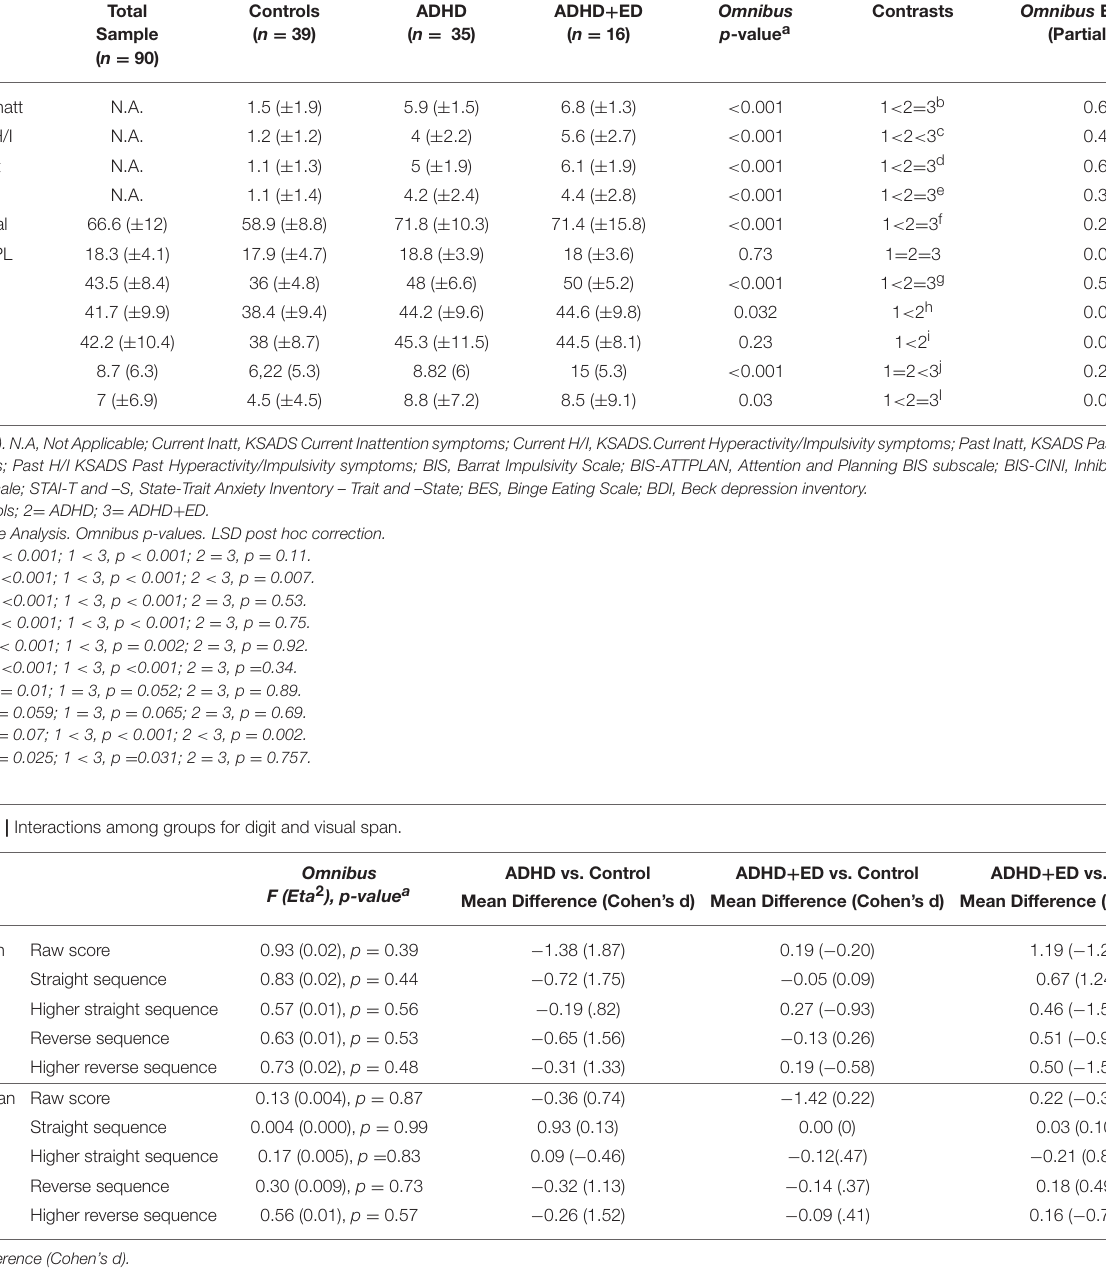
Contrasts Omnibus Effect-Size